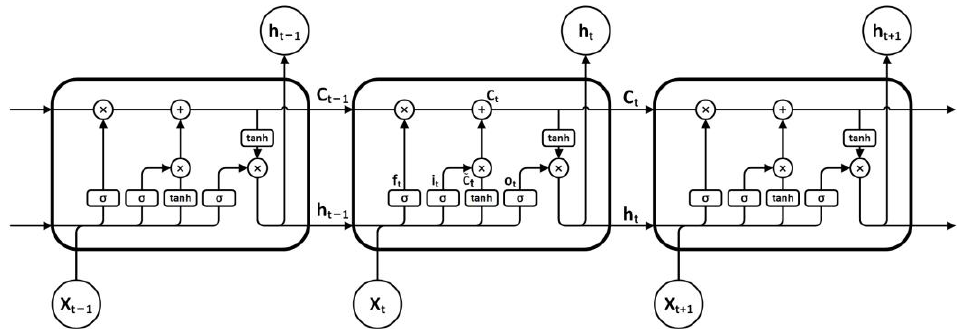
Figure 2. Illustration of LSTM.